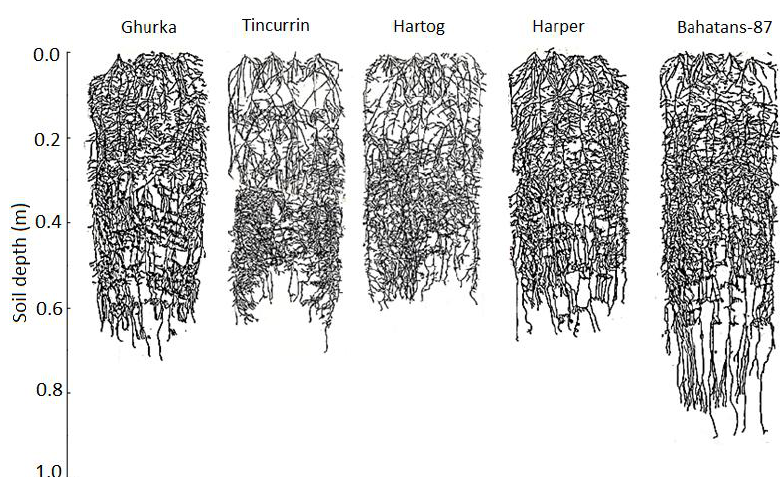
Figure 2. Example of the root distribution patterns of Ghurka, Tincurrin, Hartog, Harper and Bahatans-87 drawn on the glass panels of the rhizoboxes at 63 DAS.